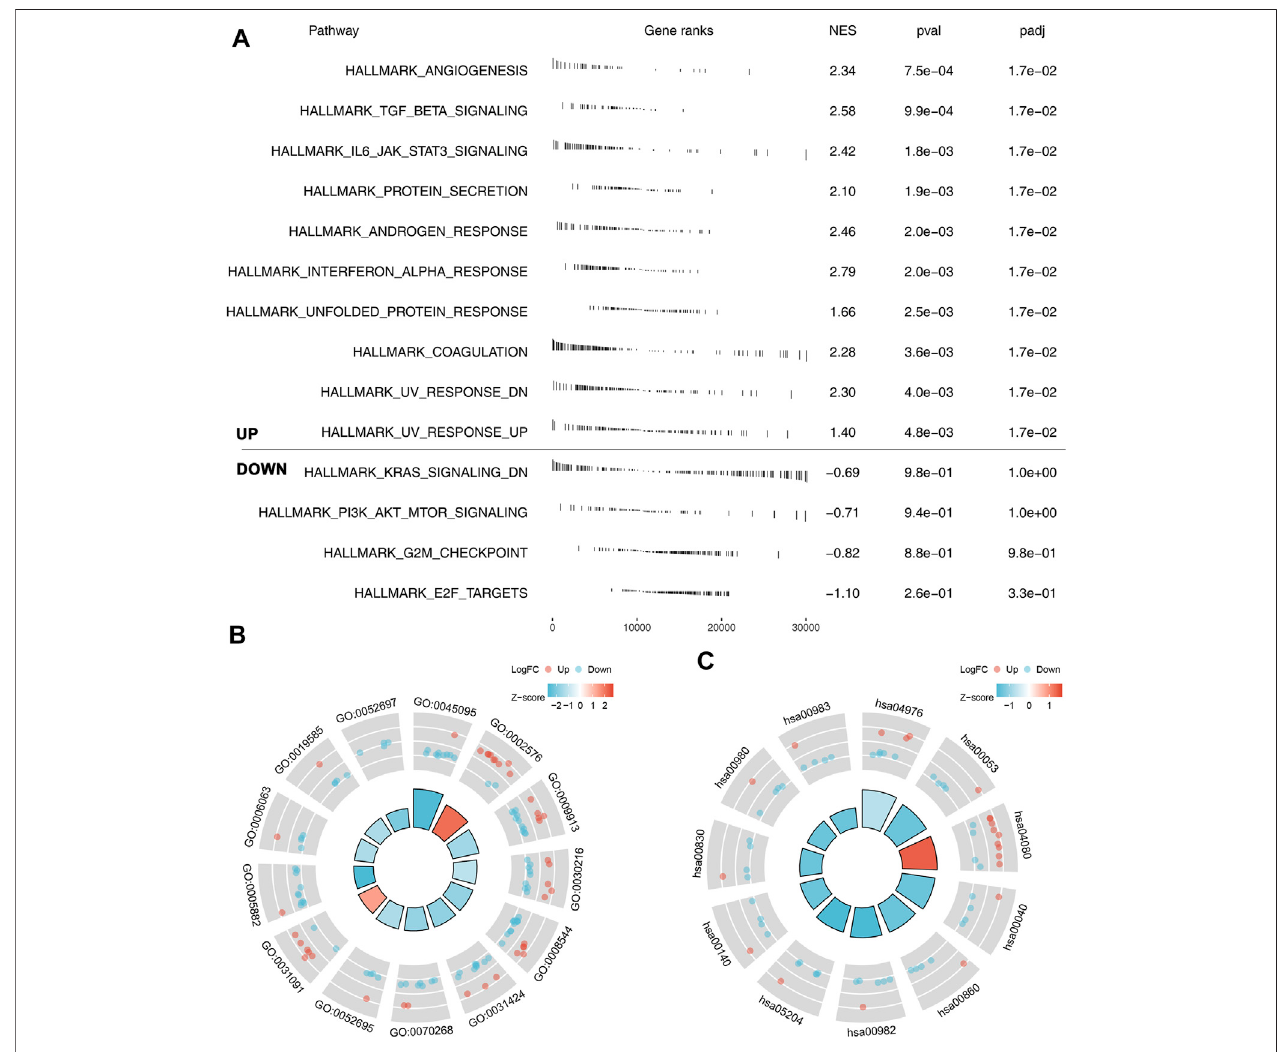
FIGURE 5 | Pathway enrichment analysis of our model. (A) GSEA analysis of the model based on the Hallmark gene set; (B) GO analysis of our model; (C) KEGG analysis of our model.